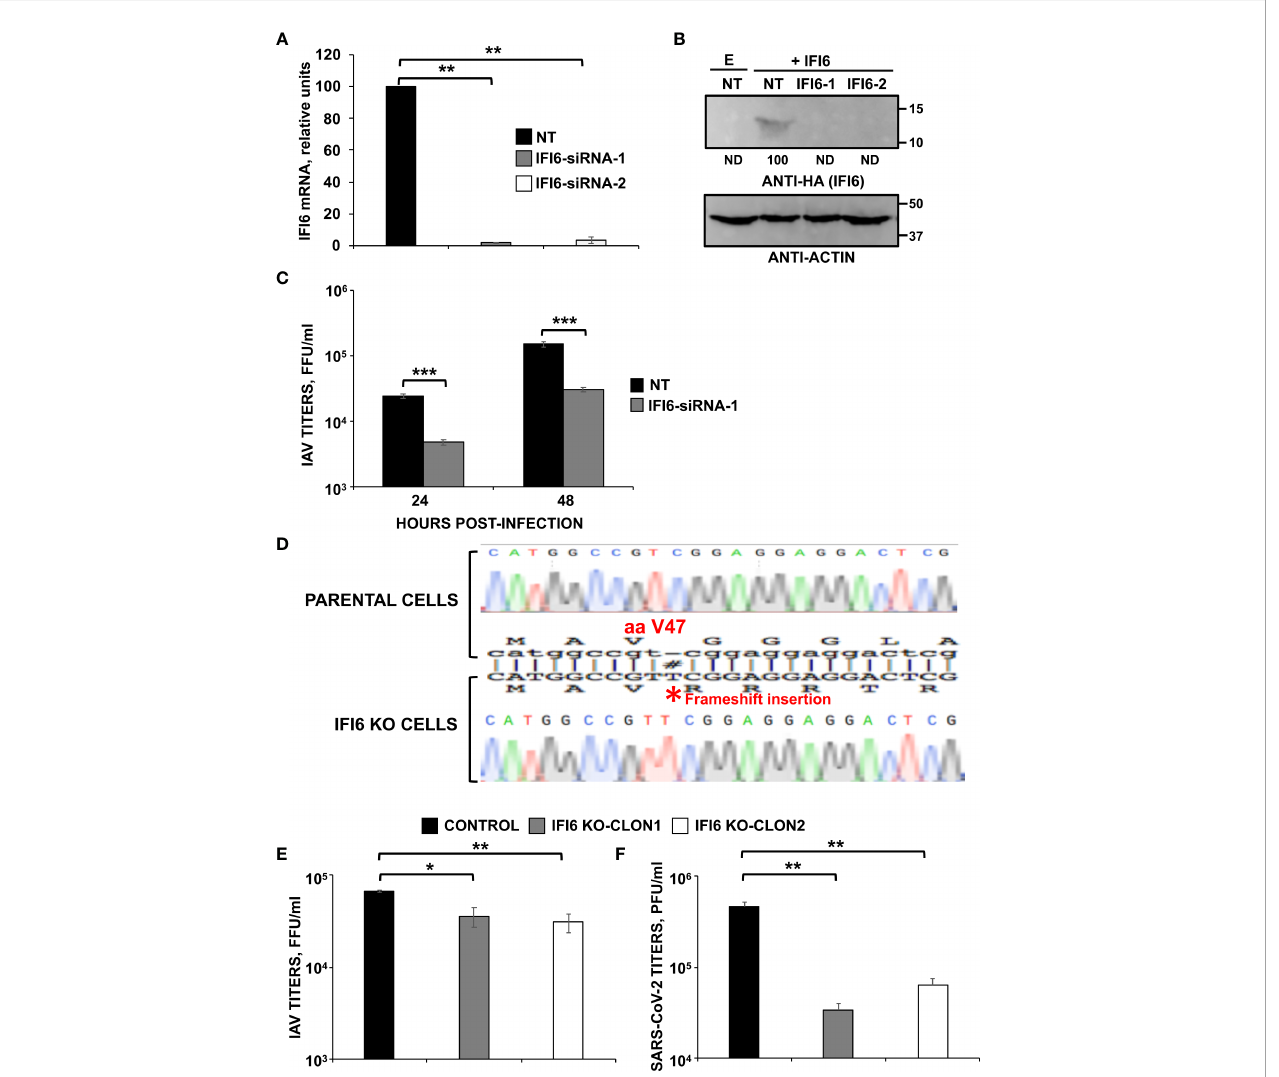
FIGURE 2 IFI6 silencing and knocking-out negatively affects viral infections. Silencing results. (A – C) Human A549 cells were transfected with a control, non- targeted (NT) or IFI6 siRNAs. (A) At 24 hpt, total RNAs were puri fi ed and used to determine the mRNA levels for IFI6 by RT-qPCR. (B) At 24 h after siRNA transfection, cells were transfected with the plasmid expressing IFI6 fused to an HA tag of with an empty plasmid, as control, during 24 h. A Western blot analysis using anti-HA antibodies (to detect IFI6; top) and anti-actin antibodies (bottom) was performed. Molecular weight markers are indicated (in kDa) on the right. Western blots after the IP were quanti fi ed by densitometry using ImageJ software, and the amounts of IFI6-HA were normalized to the amounts of actin (numbers below the top blot). ND, not detected. Three different experiments were performed, with similar results. (C) At 24 hpt, cells were infected with IAV. At 24 and 48 hpi, cell culture supernatants were collected and titrated by immunofocus assay. Three different experiments were performed, with similar results. **P<0.01, ***P<0.001 (for comparisons between NT- and IFI6-silenced cells at 24 and 48 hpi using Student´s t test). Knocking-out results . (D) Generation of IFI6 knock-out (KO) cells. Sequencing of A549 parental cells and IFI6 A549 KO cells, showing the insertion of 1 nucleotide within the open reading frame of IFI6 (bottom), in comparison to parental cells (top). The amino acid position (40) at which the insertion occurred is indicated, #, indicates an insertion within the sequence alignment. (E) Distinct clones of A549 cells speci fi cally KO for the IFI6 gene were infected with IAV. Viral titers in cell culture supernatants were measured at 24 hours post-infection (hpi) by immunofocus assay in MDCK cells ( fl uorescence forming units per ml, FFU/ml) and compared to the titers in the parental, control cells. (F) A549 clones speci fi cally KO for IFI6 and overexpressing hACE-2, were infected with SARS-CoV-2. Viral titers in cell culture supernatants were measured at 48 hpi, by a plaque assay in Vero E6 cells (plaque forming units per ml, PFU/ml), and compared to the titers in the parental, control cells. Three different experiments were performed, with similar results. *P<0.05, **P<0.01, (for comparisons between parental IFI6 KO cells using Student´s t